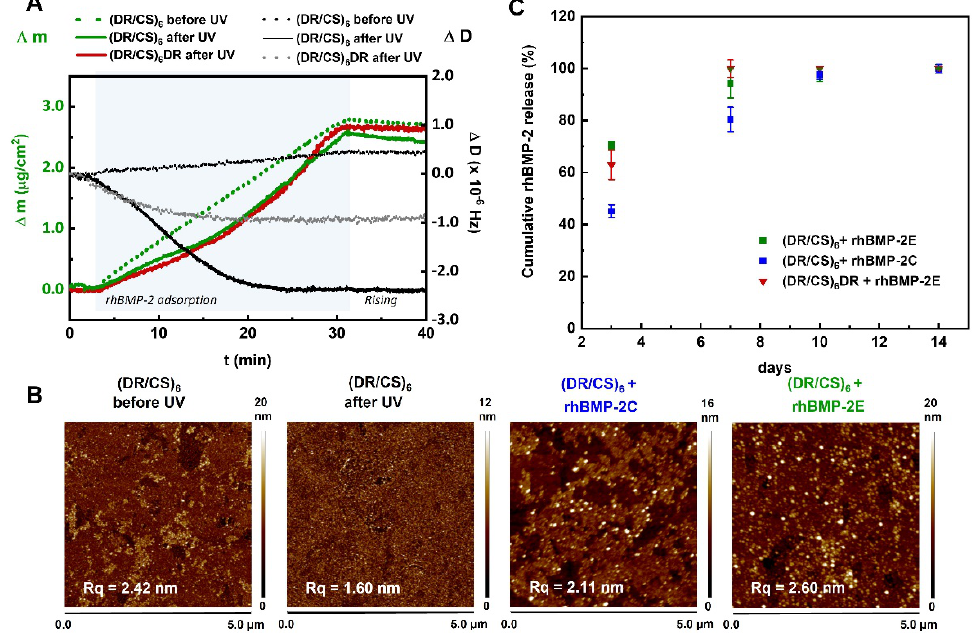
Figure 6. ( A ) rhBMP-2 adsorption/desorption QCM-D measurement using the Au/SiO 2 sensor coated with (DR/CS) 6 before photocrosslinking (dotted curves) and (DR/CS) 6 and (DR/CS) 6 DR after photocrosslinking (solid curves), expressed as the mass shift (green and red curves) and dissipation shift (black and grey curves). rhBMP-2 was used as an aqueous solution of 1 μg/mL, pH 6.2, and flow rate of 0.15 mL/min, adhered for 30 min (blue area). ( B ) Representative topography images of (DR/CS) 6 multilayers in the liquid state before and after photocrosslinking and after the deposition of rhBMP-2 from 1 μg/mL solution: covalent and electrostatic bonding. Measurements were performed in sterile water at room temperature using tapping mode. The root-mean-square roughness (Rq) values corresponding to each image are shown. ( C ) Release of rhBMP-2 detected by ELISA from surfaces of different types.